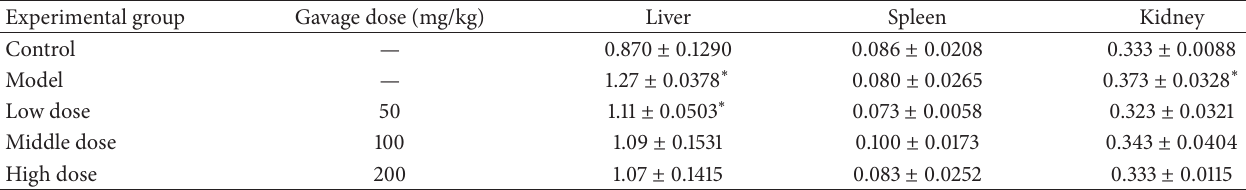
Table 5: The effect of BBE on the tissue weight of STZ-induced diabetic mice.